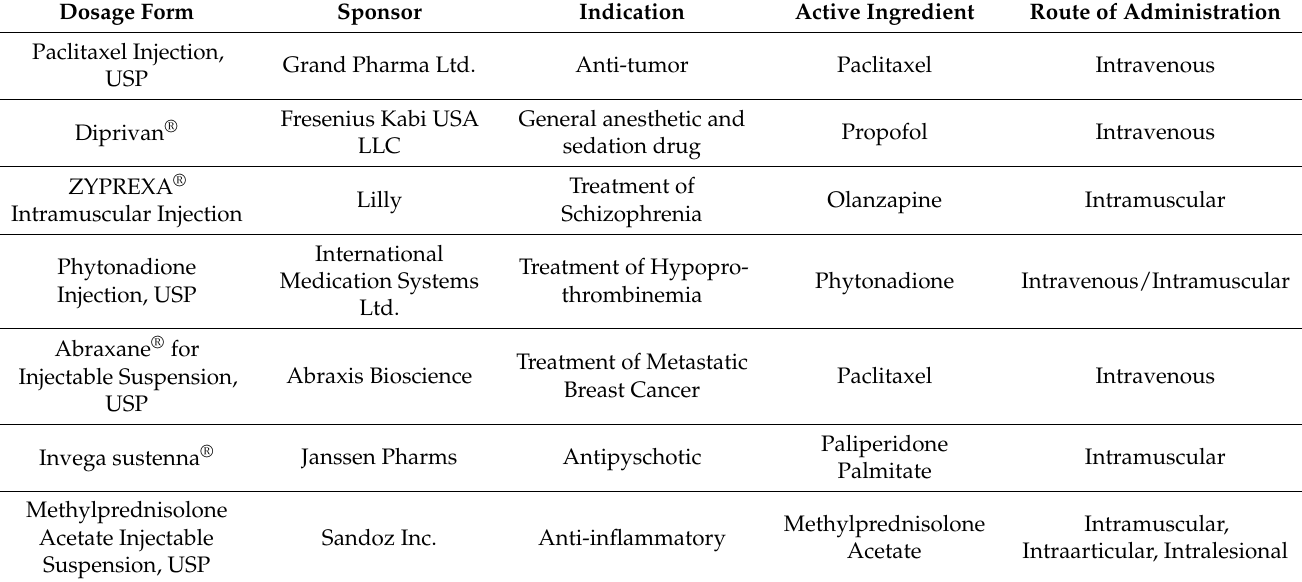
Table 2. Over-view of parenteral nanomedicines approved by USFDA (https://www.accessdata.fda.gov/scripts/cder/daf/). Dosage